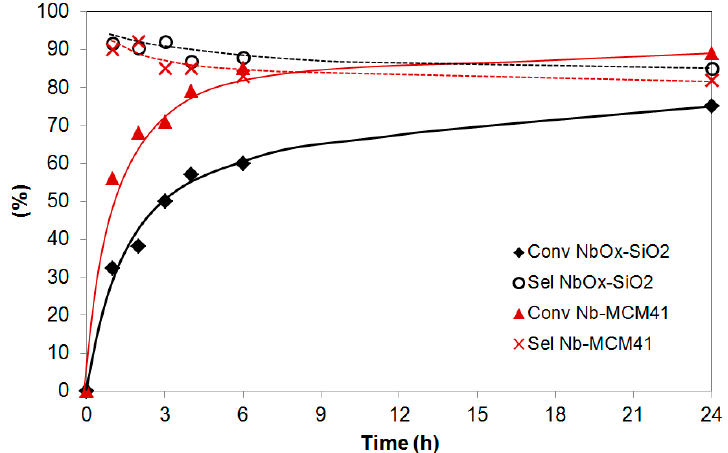
Figure 4. Conversion of methyl oleate, MO (solid lines) and selectivity to methyl epoxystearate (dashed lines) vs. time over NbO x -SiO 2 (black symbols) and Nb-MCM-41 (red symbols). Reaction conditions: glass batch reactor, 100 mg catalyst, 1 mmol MO, 4 mmol aq. H 2 O 2 , 90 °C, 300 rpm, 5 mL CH 3 CN.